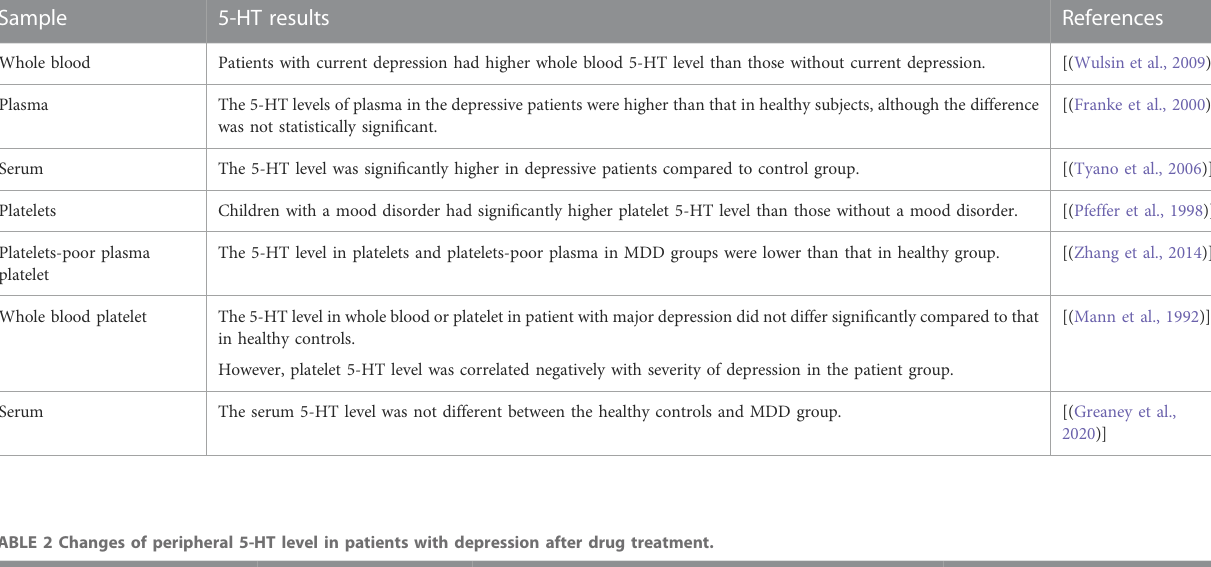
TABLE 1 Periphery 5-HT levels in depressive patients compared to normal subjects. Sample